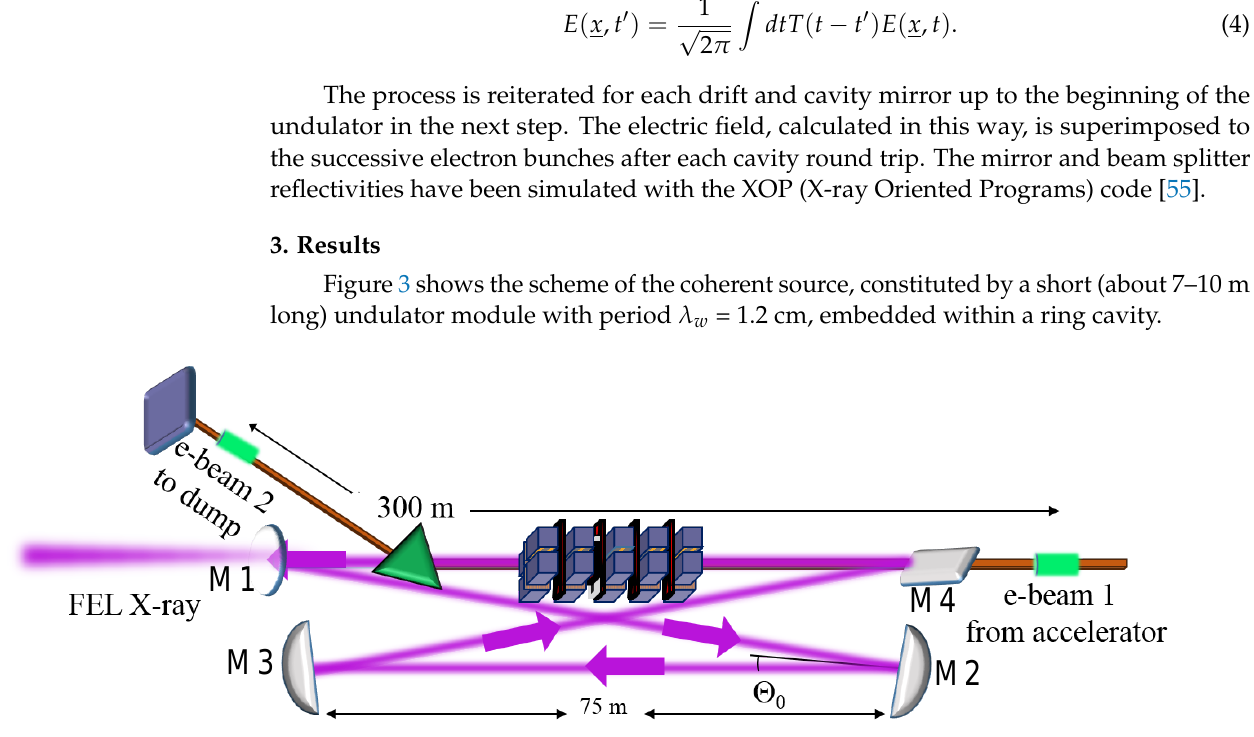
Figure 3. Scheme of the X-ray FEL Oscillator: λ w = 1.2 cm undulator module within a ring cavity made of three Diamond mirrors ( M 2 , M 3 and M 4 ) and one beam splitter ( M 1 , outcoupling the radiation). The X-ray radiation is emitted from right to left. Θ 0 is the incidence angle on the cavity mirrors with respect to the normal. The distance M 1,4 – M 3,2 between two mirrors is 75 m, giving a cavity round trip length of 300 m, equal to the distance between two successive electron